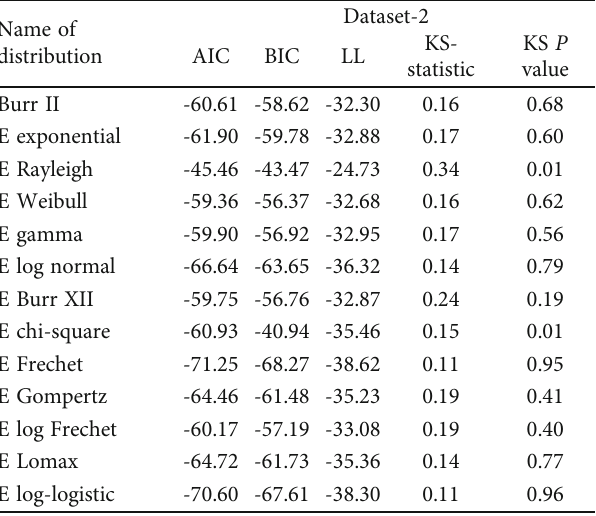
Table 20: Comparison of BT-IID with class of BEGDs using dataset-2.